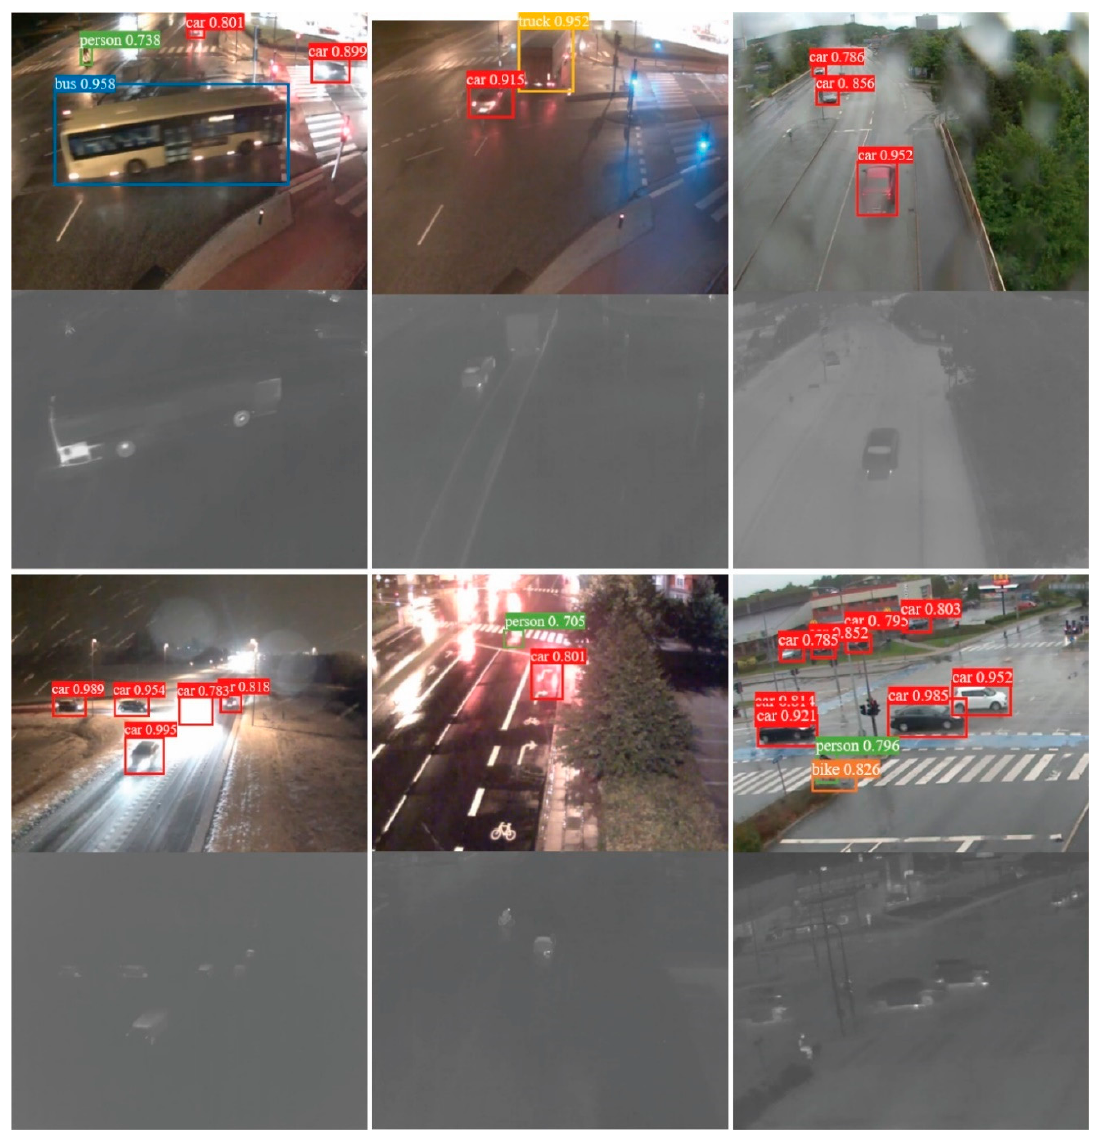
Figure 7. Some traffic object detection results for good weather and bad weather. Figure 7. Some tra ffi c object detection results for good weather and bad